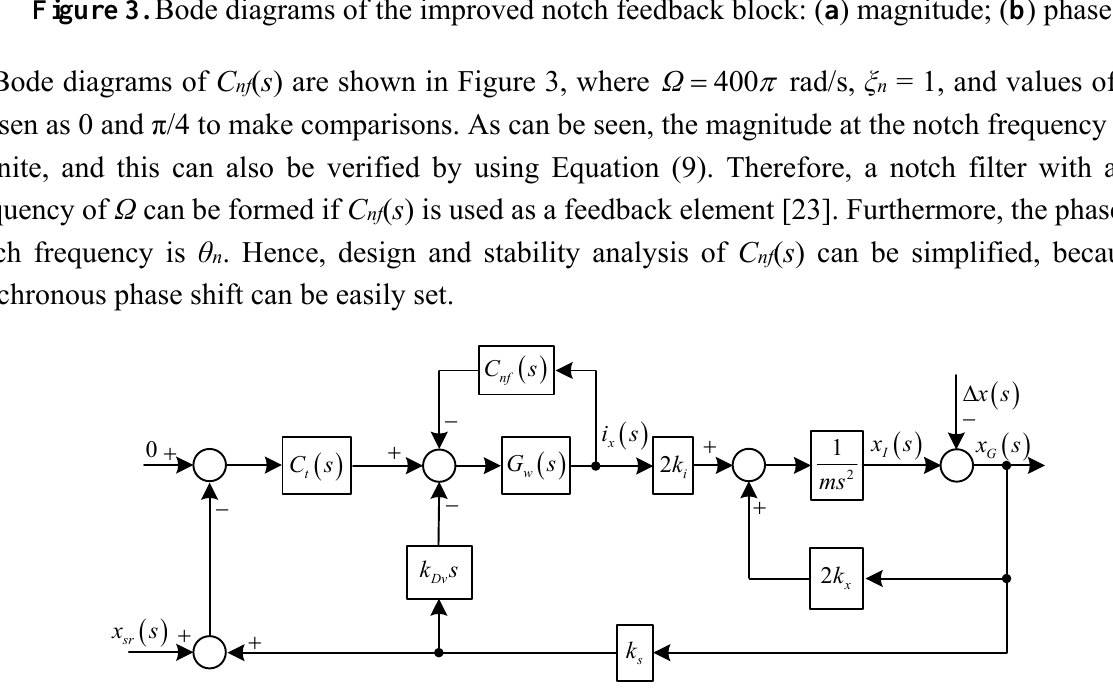
Figure 3. Bode diagrams of the improved notch feedback block: ( a ) magnitude; ( b ) phase.